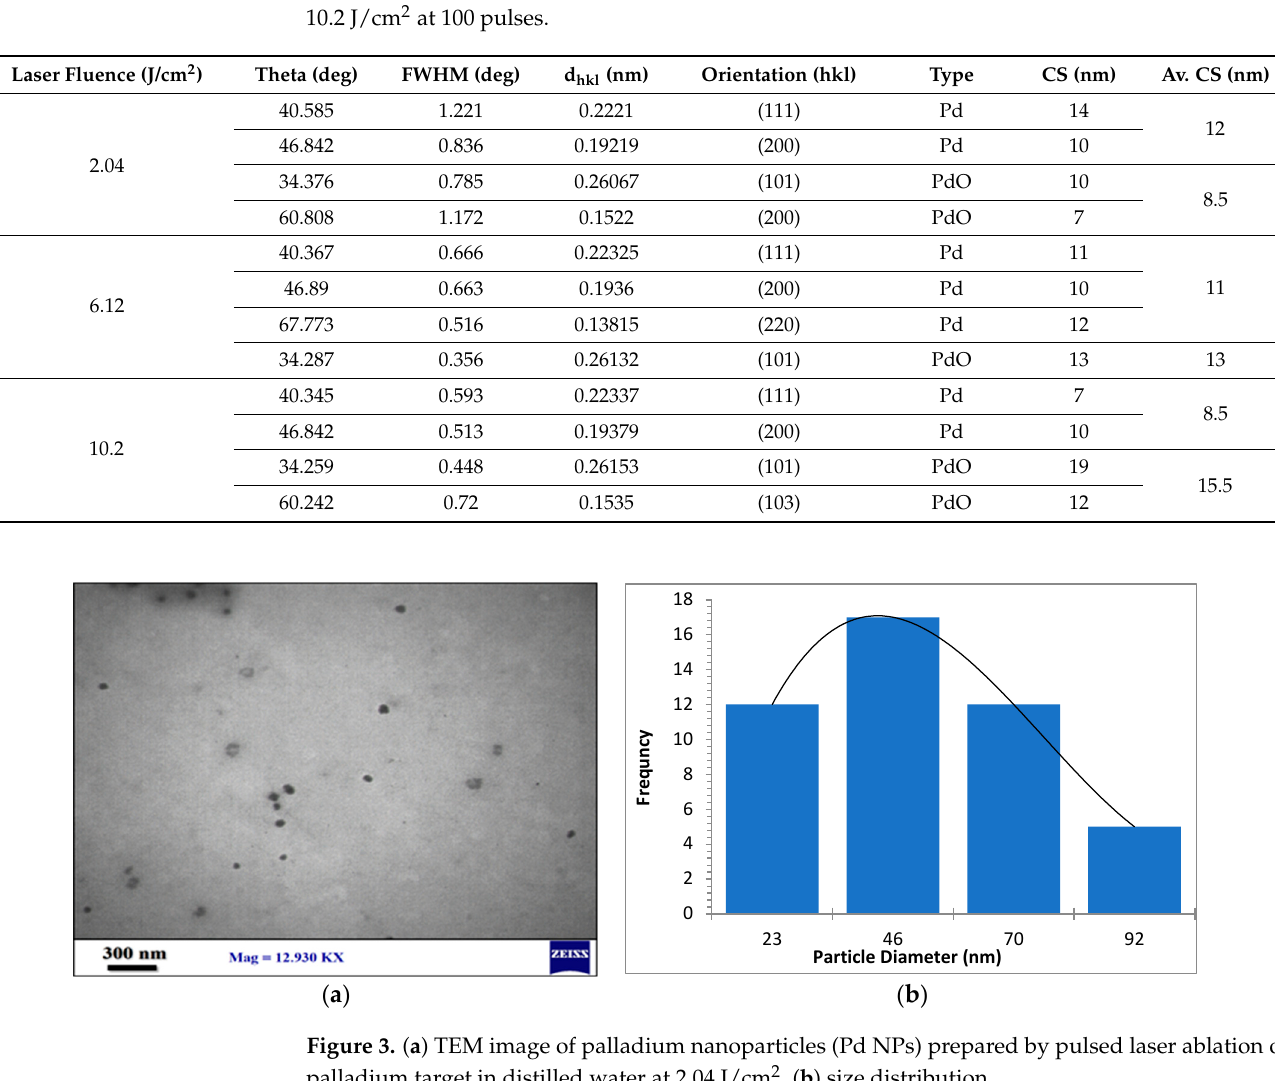
( b ) Figure 5. ( a ) TEM image of palladium nanoparticles (Pd NPs) prepared by pulsed laser ablation of palladium target in distilled water at 10.2 J/cm 2 , ( b ) size distribution. Figure 6 illustrates the UV visible spectra of palladium nanoparticles prepared by pulsed laser ablation of a palladium target in distilled water with 100 pulses at different laser fluences. The obtained UV-vis absorption spectra show broad absorption bands, which correspond to typical inter-band transitions of metallic systems and are most likely due to ionic Pd 2+ absorbance. The spectra clearly show that as the laser fluence increases, the absorption edge shifts towards longer wavelengths (red shift). The shift in the maxi- mum absorption edge could be due to crystallite size increasing with laser fluence. This is supported by the TEM and size distribution diagram analyses (Figures 3–5) [39,40,43]. Furthermore, the intensity of the absorbance varies dramatically with laser fluence. The absorbance increases as laser fluences increase, which is due to an increase in the ratio of the resulting ablation, which leads to an increase in the number of particles absorbed by the delivering laser fluence and thus increases absorbance [30]. The particles synthesized at a laser fluence of 10.2 mJ/cm 2 had the highest absorbance. This is because the electronic energy levels in nanoparticles are not continuous, as they are in bulk materials. This can result in sharp and intense absorption features corresponding to nanoparticle inter-band transitions [43,44].